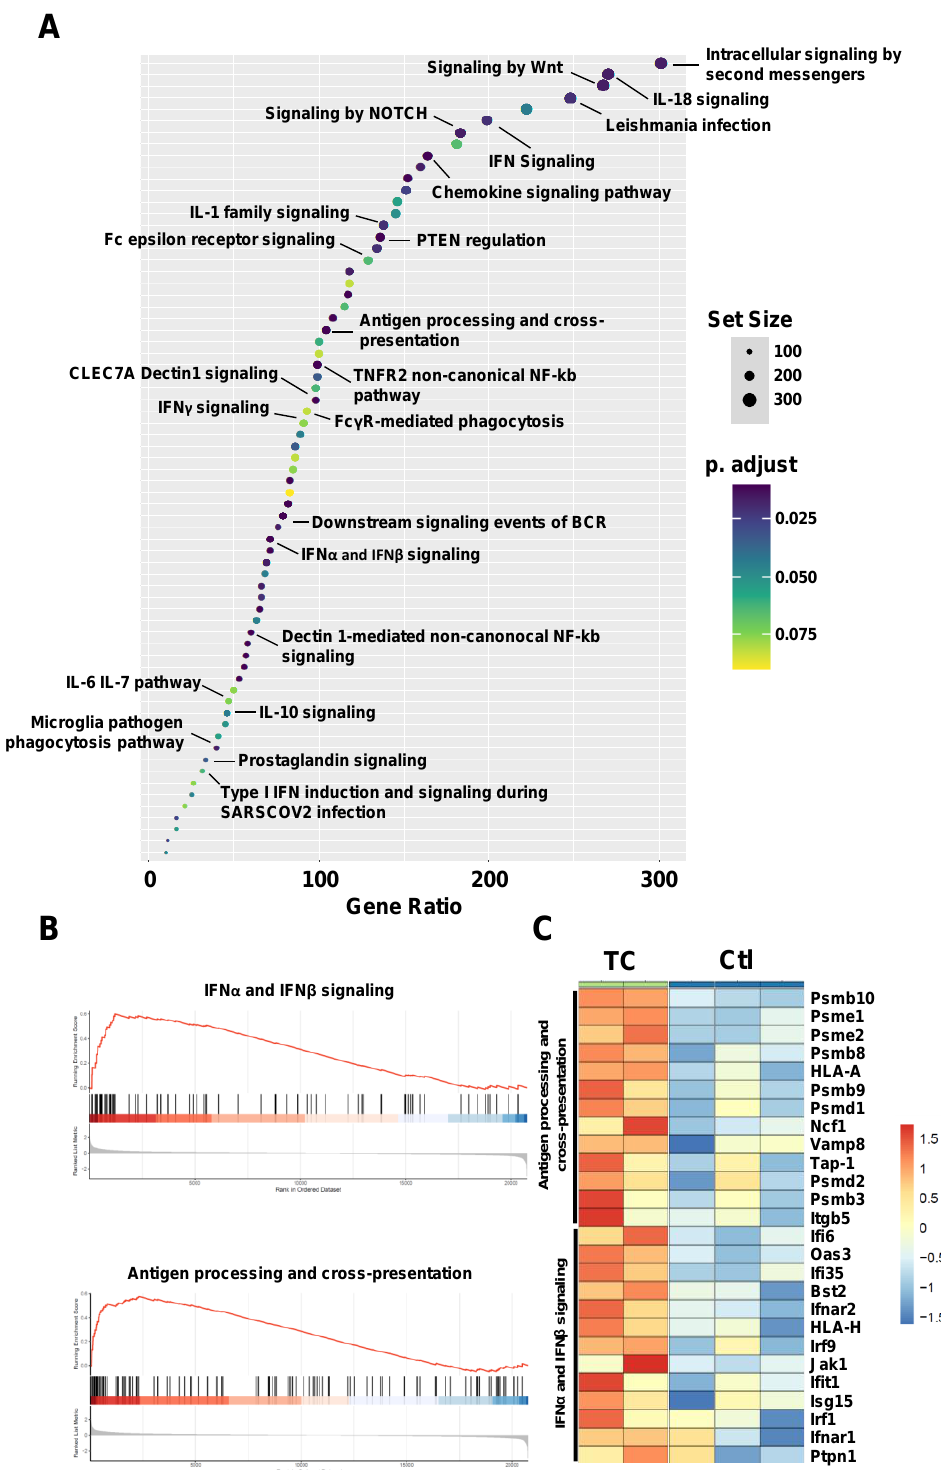
Figure 2. Bioinformatic analyses in TC-treated vs. untreated cells. ( A ) Dot plot graph showing top up-regulated reactome pathways at an FDR threshold < 10%. X -axis illustrates gene set ratio (keeping pathways with gene size between 10 and 500 for enrichment analysis). ( B ) Running-sum statistic for 2 reactome pathways: IFN α and IFNβ signaling (NES = 2; FDR = 0.1) and antigen processing and cross-presentation (NES = 2.05; FDR = 0.1). ( C ) Heat-map illustrating a set of genes that contributes most to the rank statistics from B) and significantly up-regulated using TC treatment.